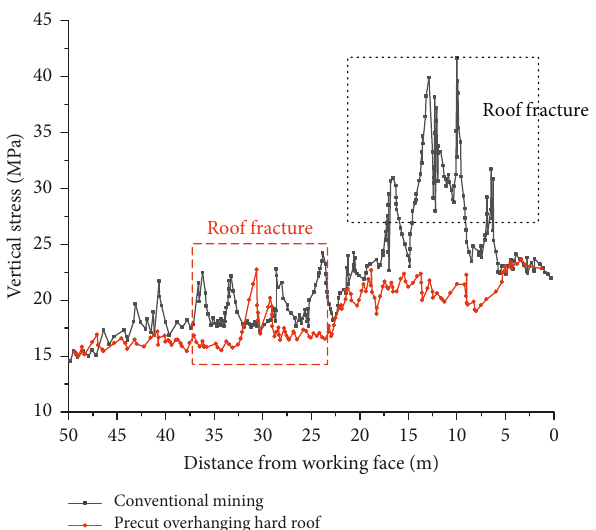
Figure 9: Dynamic evolution process of roadway roof